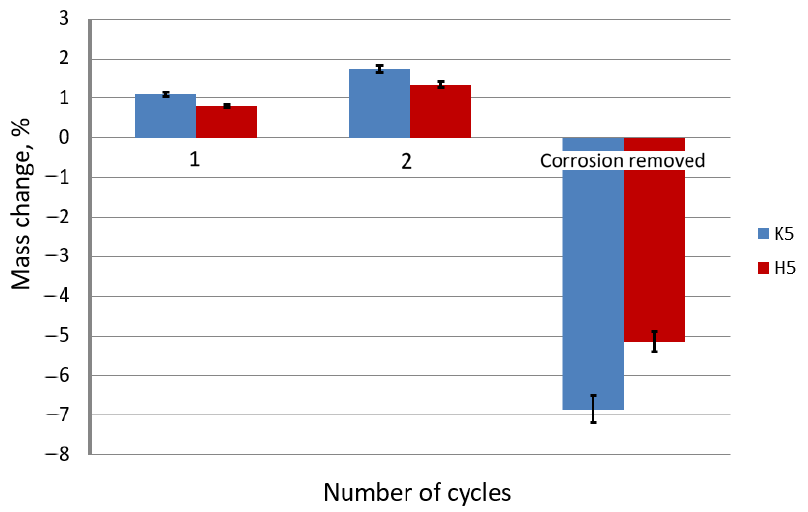
Figure 11. The percentage change in mass of the galvanized wire samples drawn at a speed of 5 m/s using the conventional K5 method and the hydrodynamic H5 method, made in a salt spray chamber, where the exposure took place in cycles.